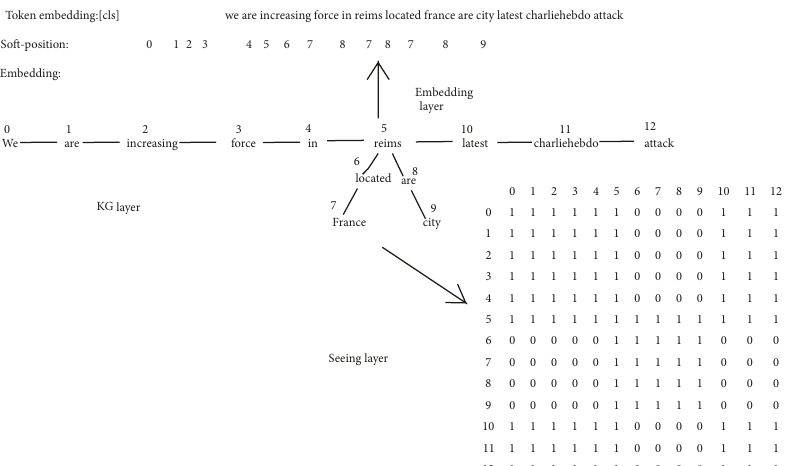
Figure 4: Schematic diagram of knowledge embedding layer, the upper left corner is embedding, and the lower right corner is the visible